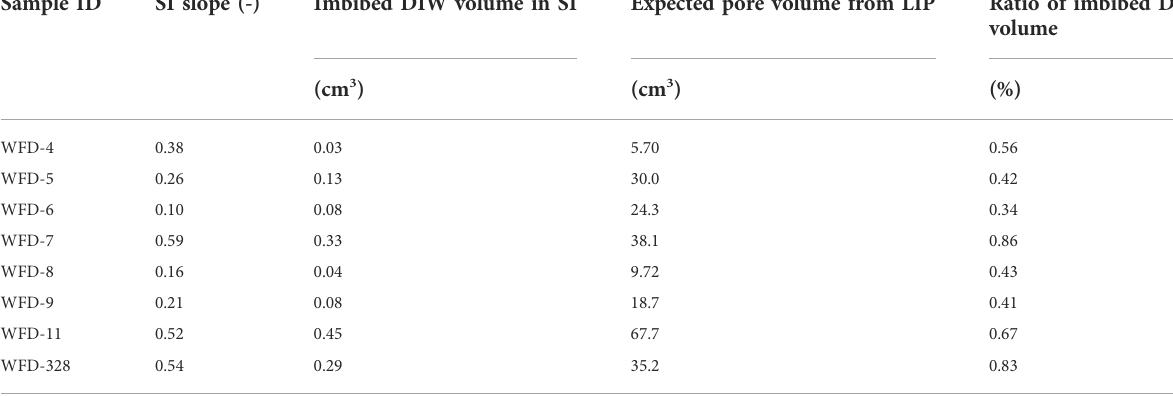
TABLE 4 Results of imbibition to T directions of Woodford Shale samples. Sample